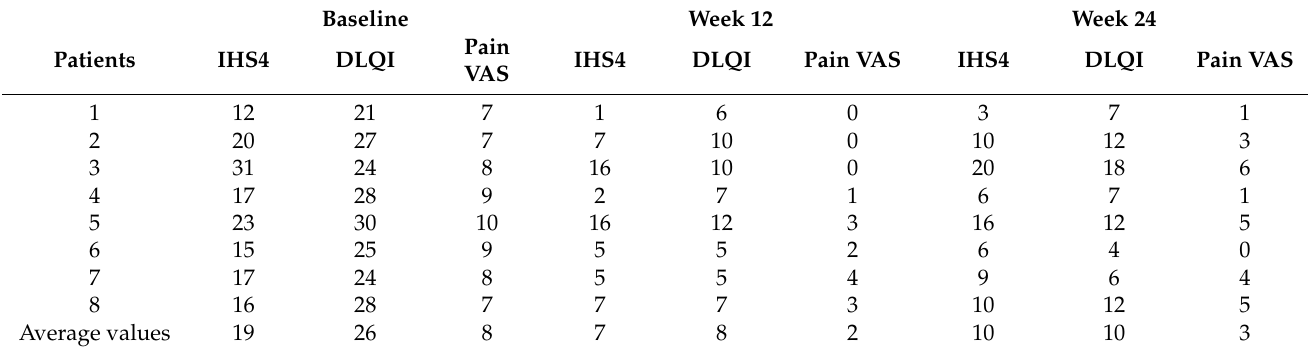
Table 5. Clinical assessment at baseline, week 12 and week